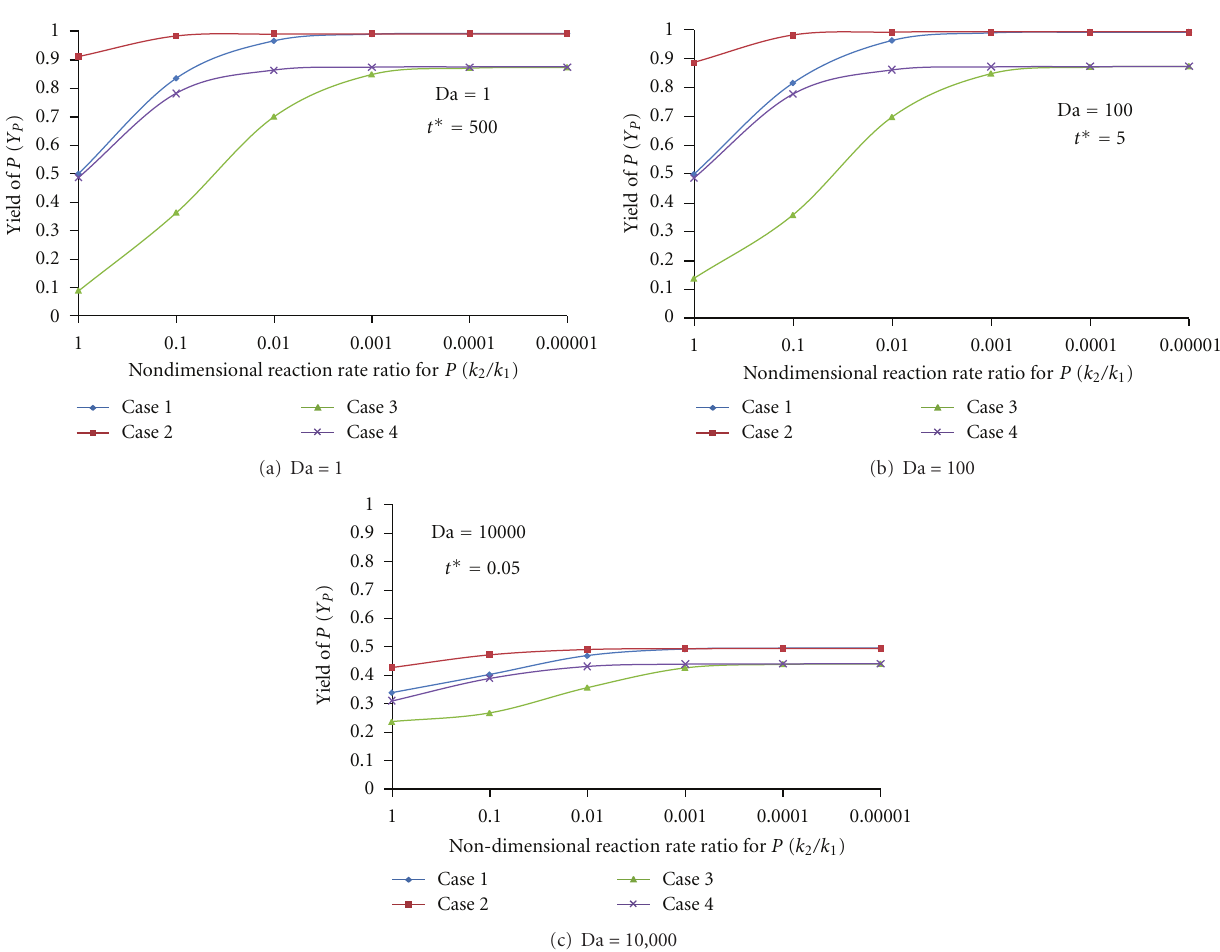
Figure 8: Plots of yield of P versus k 2 / k 1 for various Da at Da · t ∗ = 500 for C-P